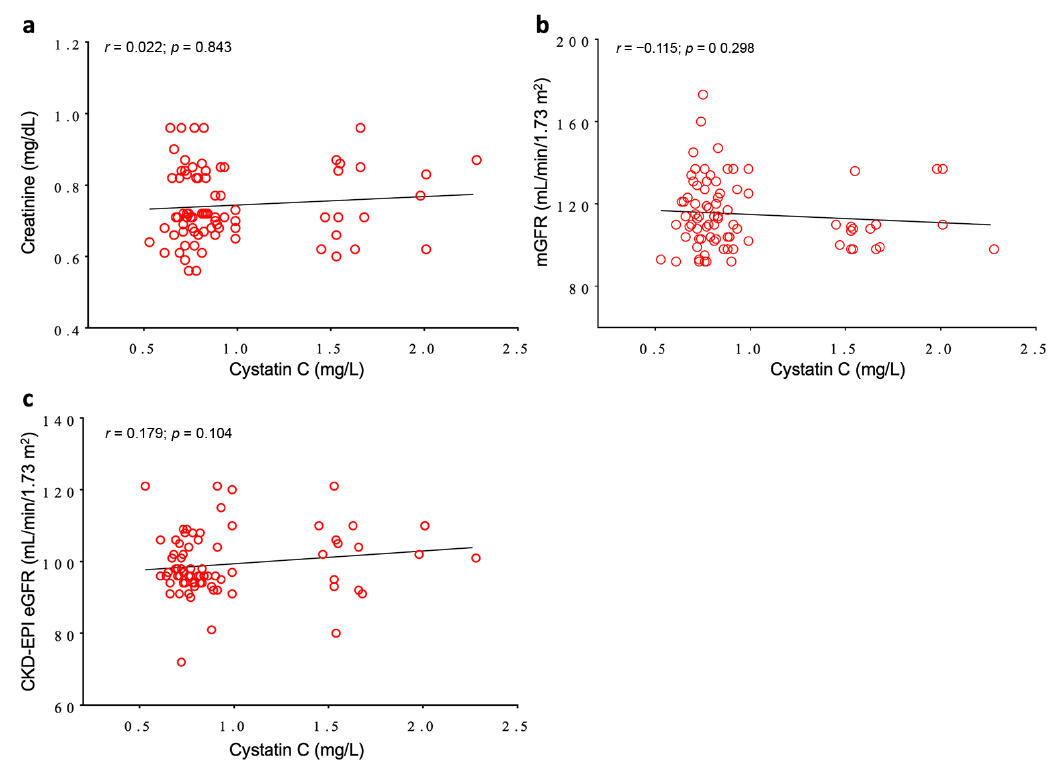
Figure 1. Pearson’s correlation analysis between Cystatin C and other renal functional parameters in the total study population. ( a ) Cystatin C (Cys-C) vs. creatinine; ( b ) Cys-C vs. mGFR; ( c ) Cys-C vs. CKD-EPI eGFR.